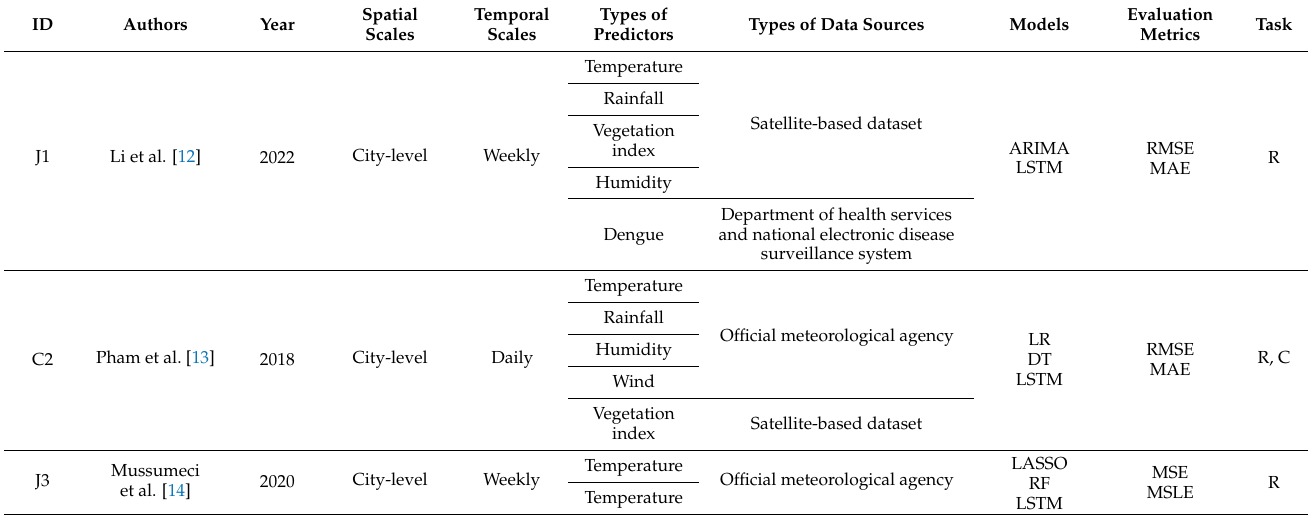
Table A1. Article ID (J: journal article, C: conference paper), authors, publication year, spatial scales, temporal scales, types of predictors, types of data sources, models, evaluation metrics, and types of tasks (R: regression, C: classification) used in the selected journal and conference